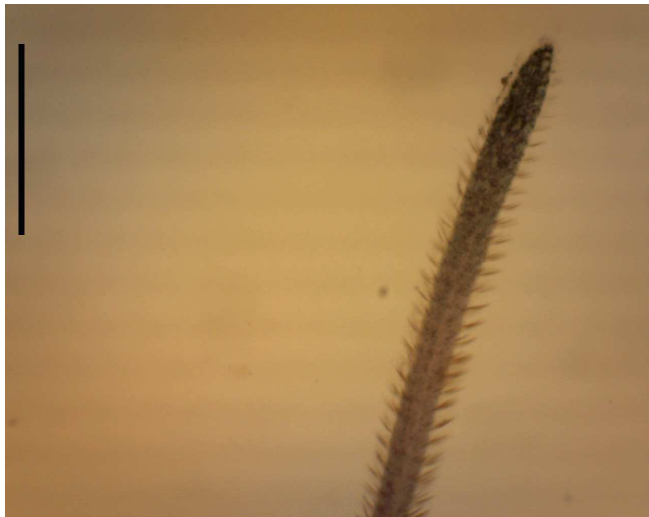
F IGURE 20. Rings of setae on antenna 4 in Heteromurus (scale: 25 µm)